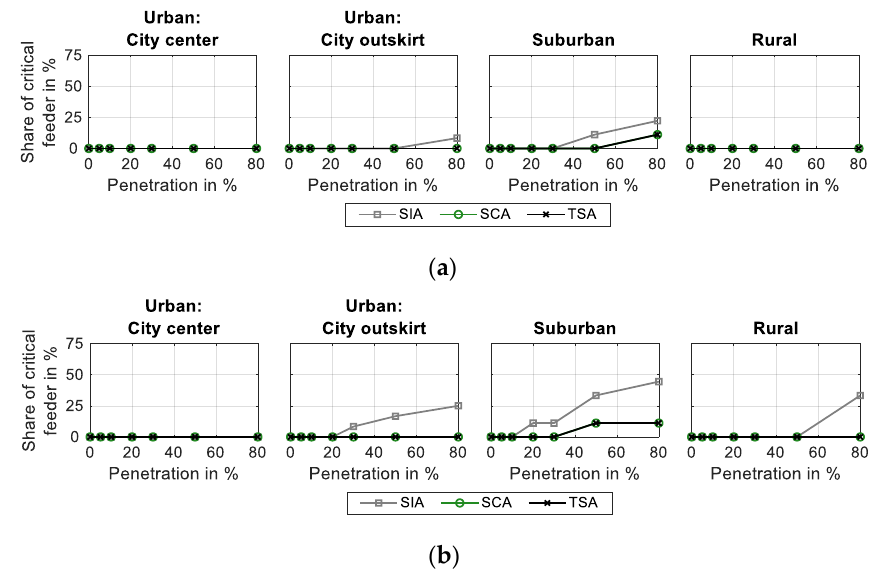
Figure 10. Share of critical feeders in terms of thermal overloads caused by CC and EV ( a ) as well as CC, EV and HP ( b ) considering various load approaches, grid regions and penetration levels.